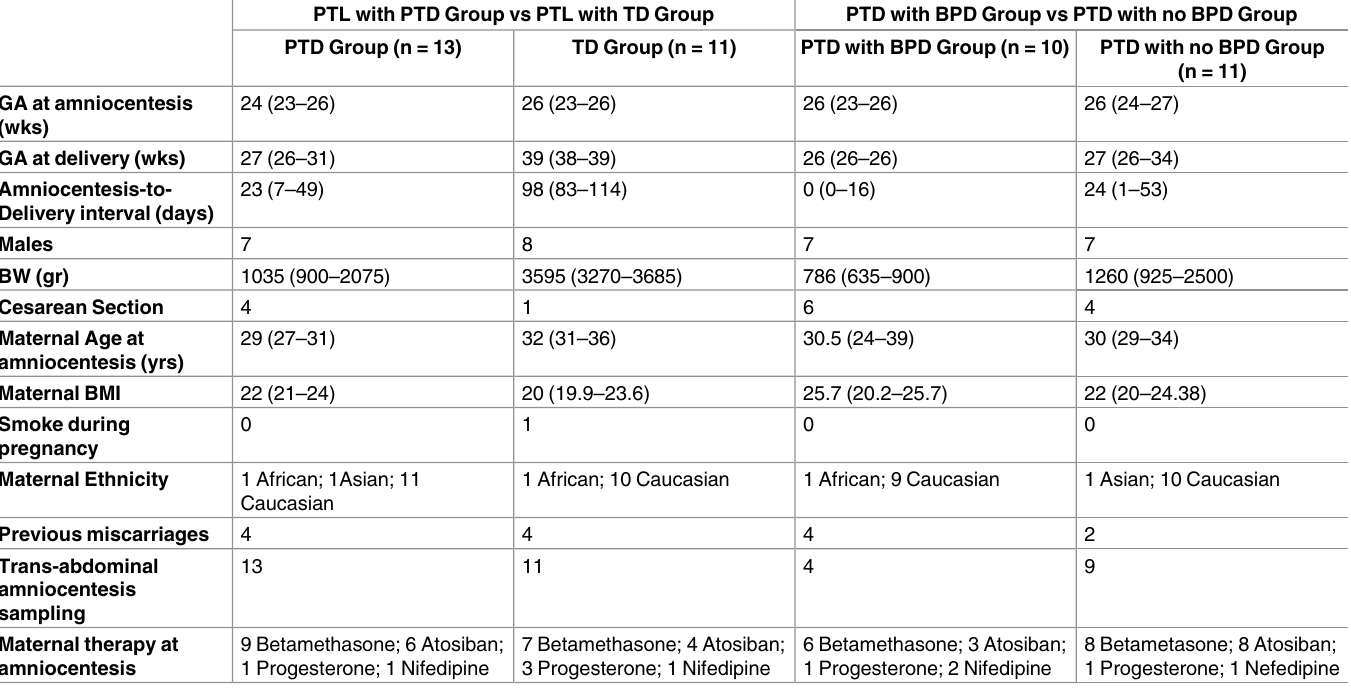
Table 1. Demographic and clinical characteristics for all the groups analyzed in our study. PTL with PTD Group vs PTL with TD